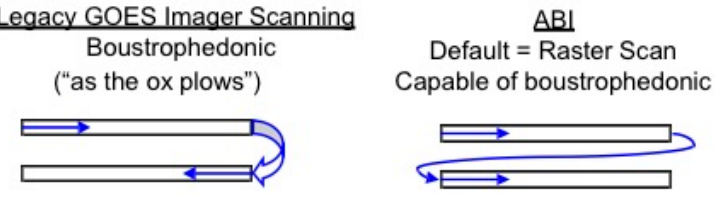
Figure 4. Scanning pattern of the legacy GOES Imagers ( left ) vs the ABI scanning pattern ( right ). Table 2. The number of frames per swath and the swath duration.